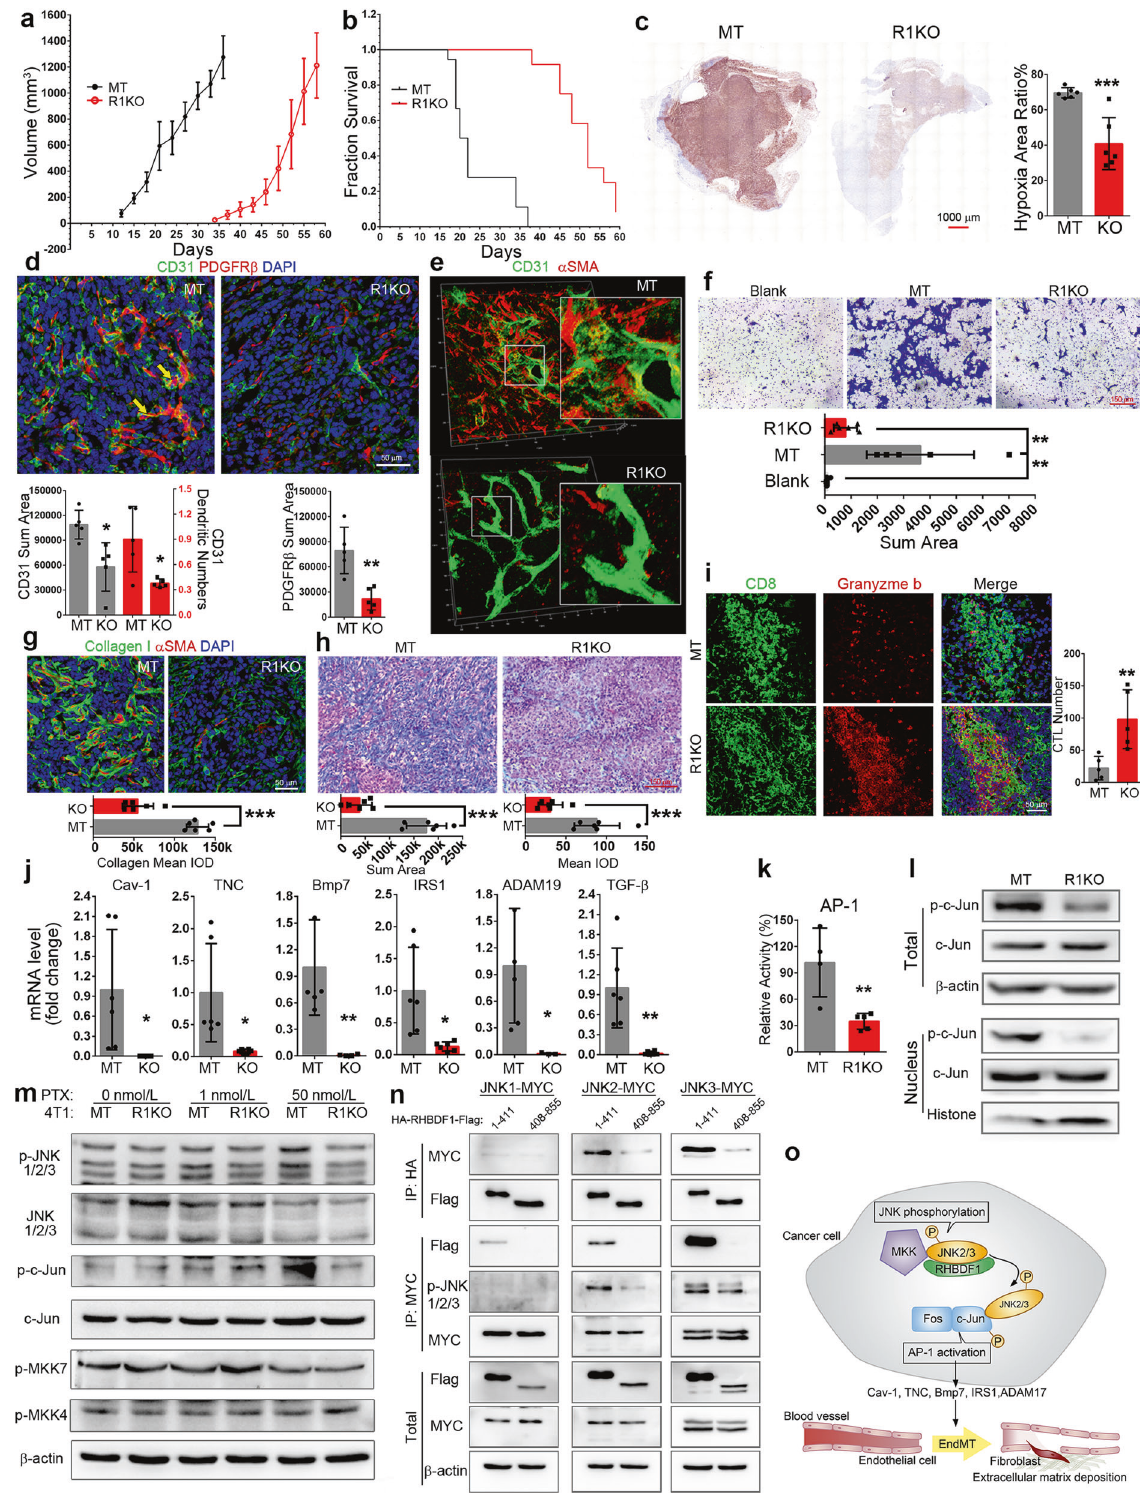
(Supplementary Fig. 4d). It is thus plausible that the RHBDF1 gene is critically involved in the modulation of AP-1-centered signaling. To investigate possible molecular mechanisms underlying the involvement of RHBDF1 in the modulation of AP-1 signaling, we fi rst determined AP-1 activity by using a luciferase-based reporter